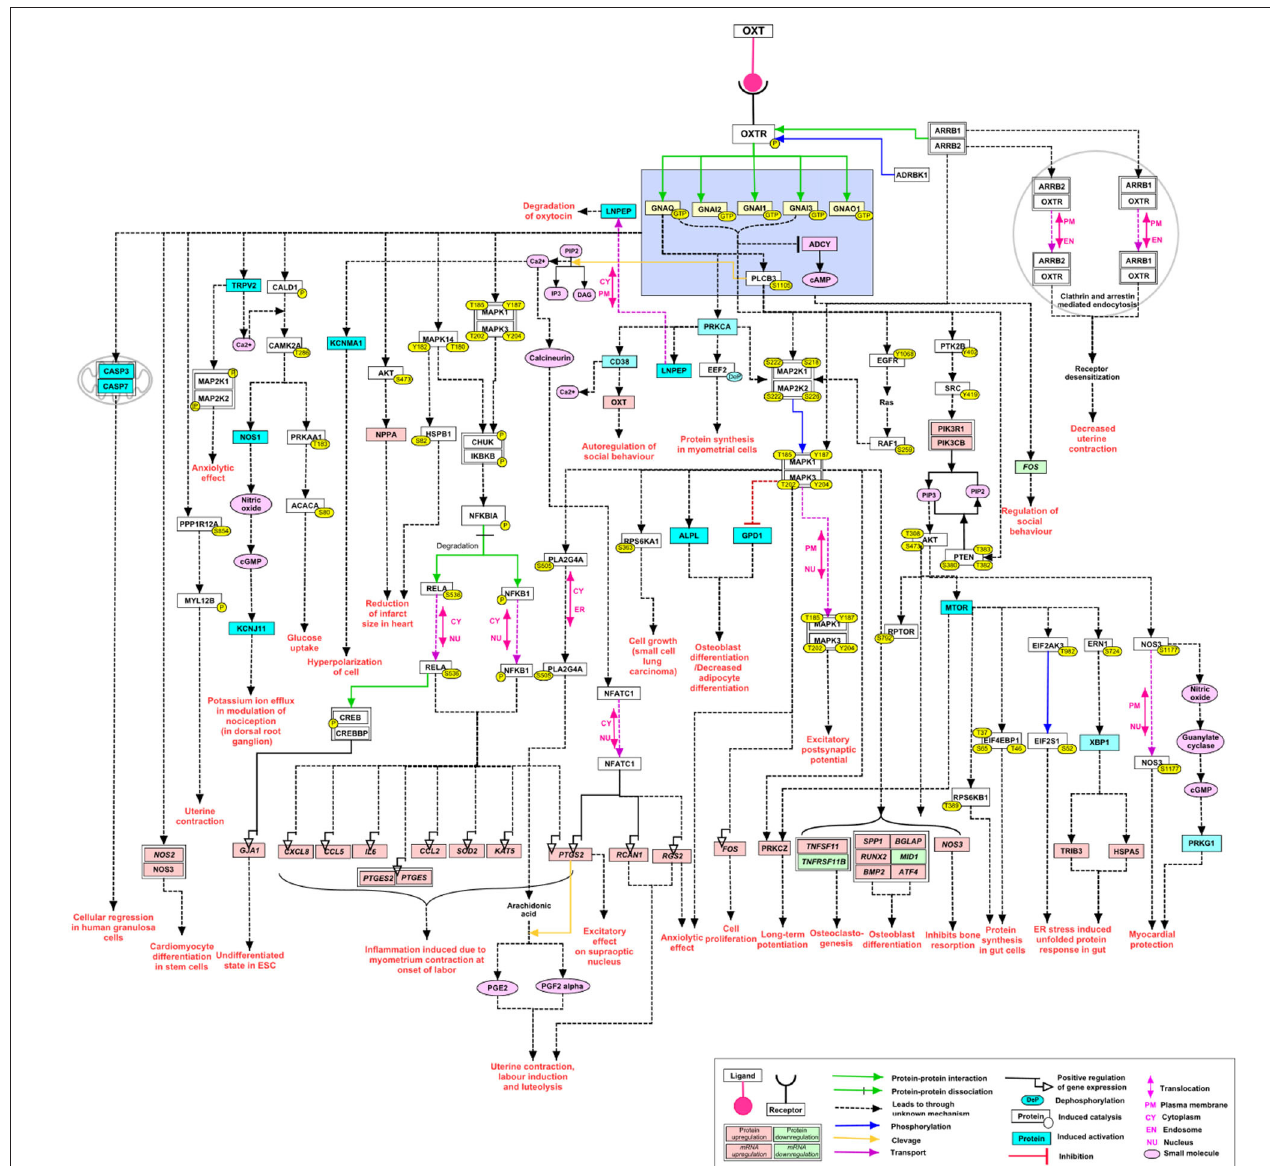
FIGURE 3 | Re-published: The complexity of the signaling pathways of the oxytocin receptor (here called OXTR) Reprinted by permission from Springer Nature: Springer Link, Journal of Cell Communication and Signaling, An overview of the oxytocin-oxytocin receptor signaling network, Chatterjee et al. (33) https://link.